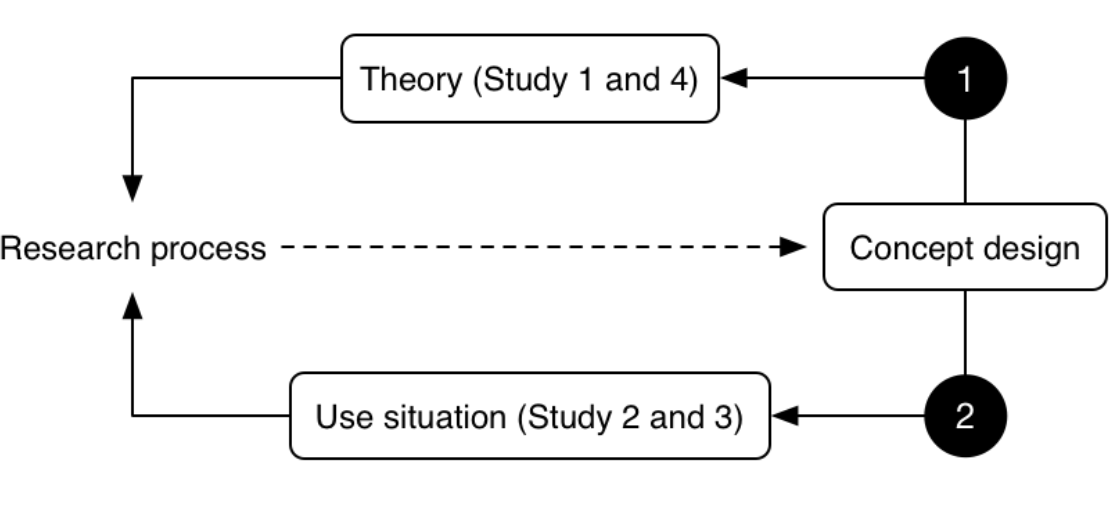
Figure 2: Below is the adapted version of the concept-driven design research approach as presented by Stolterman and Wiberg (2010, p. 101), mapping the four conducted studies to theory and use situation. The use situation in the current article is implemented by means of empirical studies and points to an event of participatory